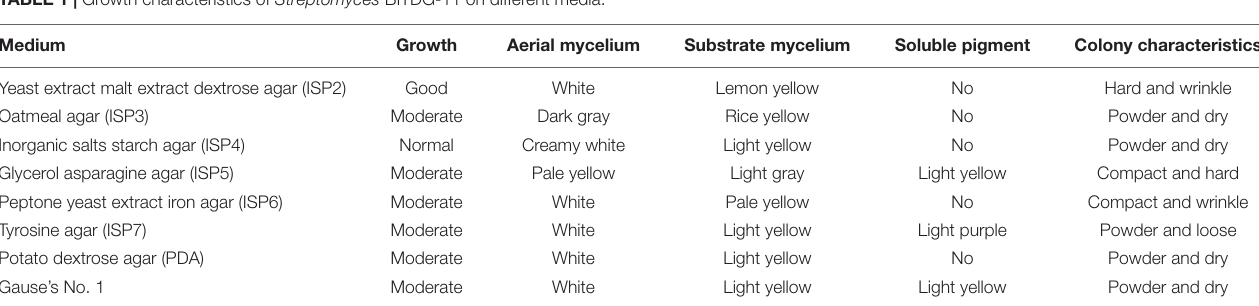
TABLE 1 | Growth characteristics of Streptomyces BITDG-11 on different